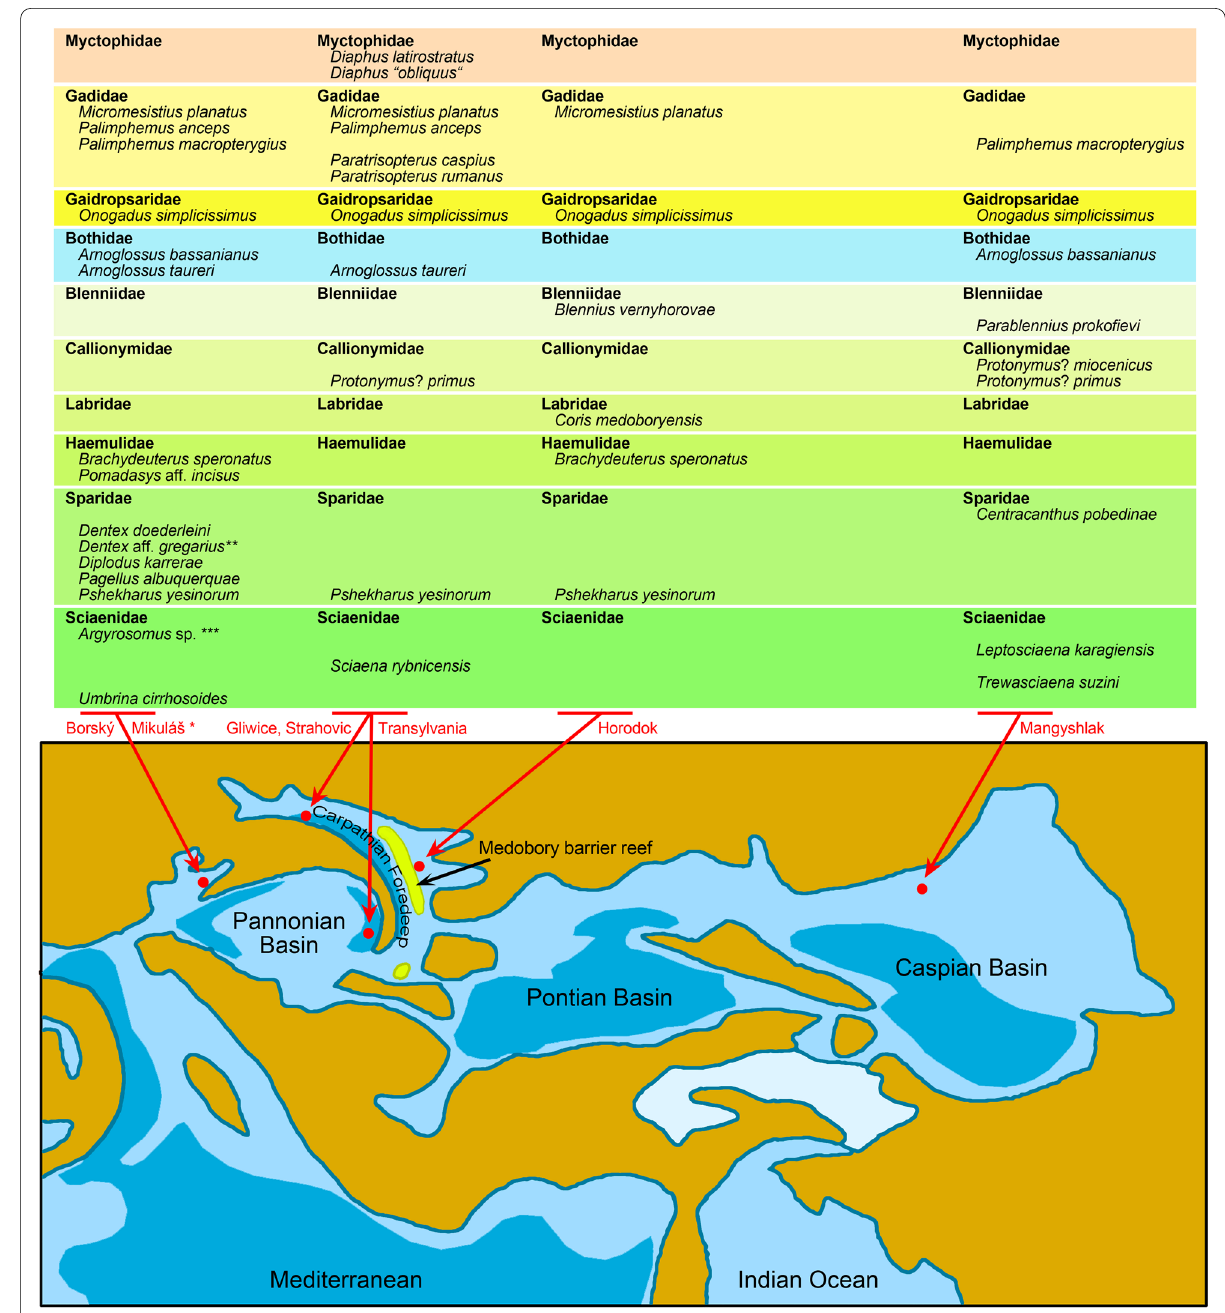
Fig. 13 Late Badenian paleogeography of the Paratethys and distribution of selected non-gobioid otolith-based taxa through the basin. Most common species are shown in bold printing. Asterisk denotes multiple locations, of which Borský Mikuláš represents the richest and most recently described otolith assemblage (Brzobohatý et al., 2022). Double asterisk for Dentex aff. gregarius tentatively includes records of Dentex aff. maroccanus by Brzobohatý et. al. (2022). Triple asterisk for Argyrosomus sp. denotes record of Argyrosomus aff. regius by Brzobohatý et. al. (2022). Paleogeography based on Rögl (1999), Popov et. al. (2004), and Kováč et. al.